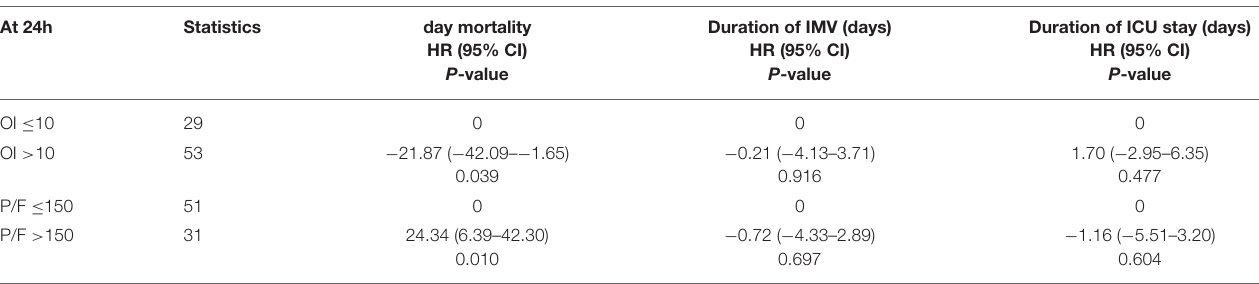
Model is adjusted for sex, age, septicemia, CRRT (24h), PIP (24h), and Lac (24 h). PIP, peak inspiratory pressure, Lac, lactate, CRRT, continuous renal replacement therapy; ICU, intensive care unit; CI, confidence interval; IMV, invasive mechanical ventilation.